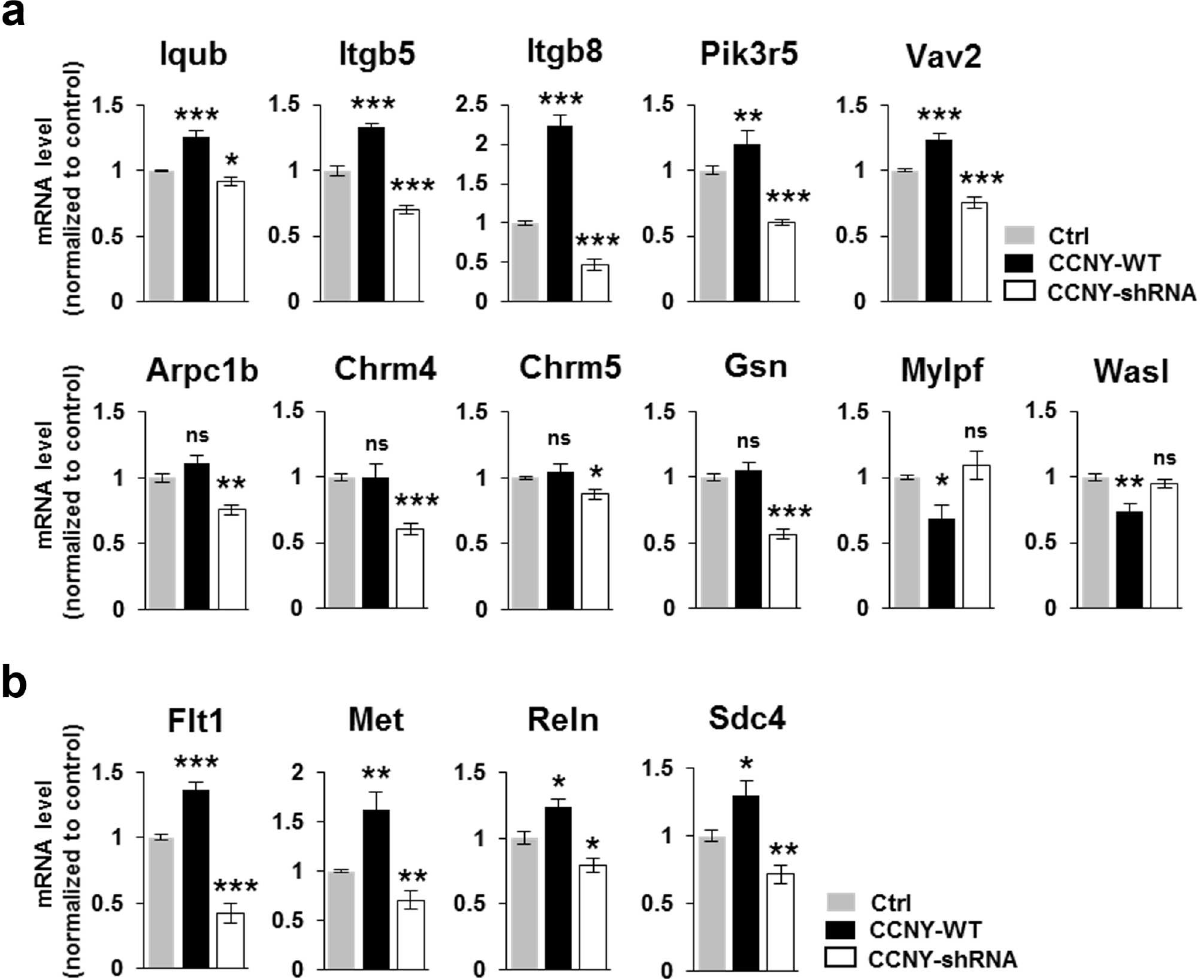
Fig 4. CCNY affectsthe pathways for the regulation of actin cytoskeleton, focal adhesion, and Extracellular Matrix (ECM)-receptor interaction in hippocampal neurons. ( a , b ) Transcript levels of severalgenesfrom “regulationof actin cytoskeleton”pathway ( a ) and “focal adhesion”and “ECM-receptor interaction” pathways ( b ) were analyzedby qRT-PCR. n = 3–5 from 3 independentexperiments. * p < 0.05 relative to control, ** p < 0.01 relative to control, *** p < 0.001relative to control, ns, not significant,student’s t test. Refer the S2 Table.